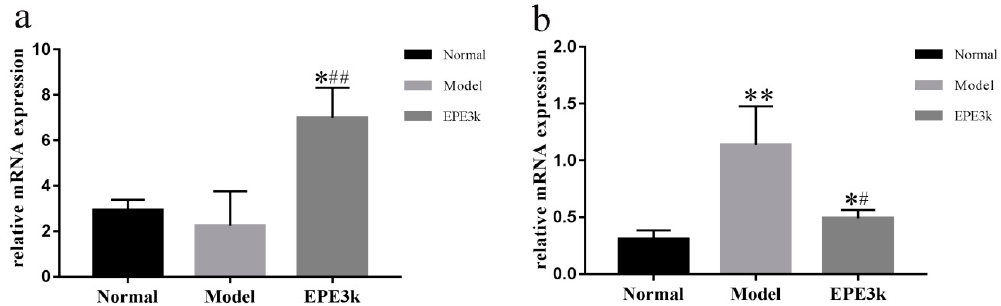
Figure 3. Effect of EPE3k on mRNA expression of PI3K ( a ) and JNK1 ( b ) in liver of type 2 diabetic mice. * p < 0.05 and ** p < 0.01; compared with normal group; # p < 0.05 and ## p < 0.01, compared with model group.